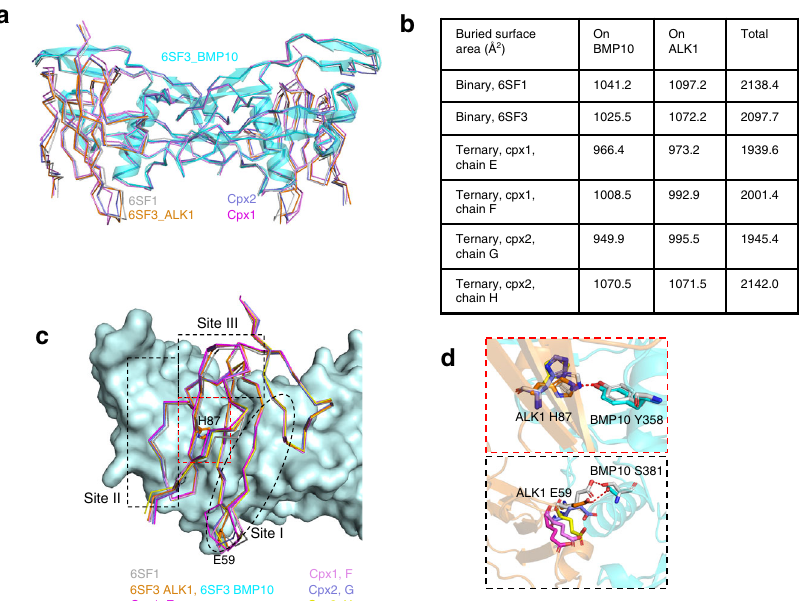
Fig. 2 Comparison of ALK1 binding sites in binary and ternary BMPRII receptor complexes. a Overlay of BMP10:ALK1 from the ternary signalling complex (cpx1, magenta, cpx2, purple) to those from binary complexes (PDB code 6SF1 in grey; 6SF3 in cyan for BMP10 and orange for ALK1). The backbones of all overlaid molecules are shown in ribbon. BMP10 from 6SF3 also shown in semi-transparent cartoon. Because in both 6SF1 and 6SF3, there was only one copy of BMP10:ALK1 monomer in an asymmetric unit, the dimeric receptor complexes for 6SF1 and 6SF3 were generated with a symmetry- related molecule and the two BMP10:ALK1 interfaces in 6SF1 and 6SF3 dimer would be identical. b Comparison of the buried surface area at the BMP10 and ALK1 interface in binary and ternary receptor complexes. c Overlay of all ALK1 chains, displayed in ribbon on BMP10 surface (light cyan). Four parts of BMP10 binding sites on ALK1 identi fi ed previously 13 are highlighted by dashed lines. The colour for each chain is shown below. d Zoomed-in views of ALK1 H87 and E59 interaction area. H-bond interactions are shown with dotted lines. Same colour scheme as in c . The only interactions can be seen are in grey (from 6SF1), and orange and cyan (from 6SF3). Detailed information and the list of the interactions can be found in Supplementary Table